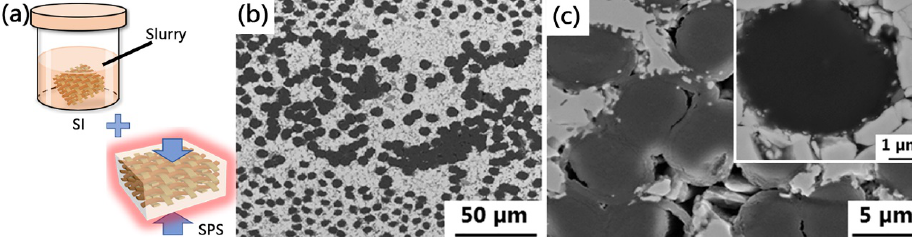
Fig. 20 Schematic diagram of vacuum slurry impregnation and SPS (a); microstructure of the polished SPS–C f /ZrB 2 –SiC composites (b, c). Reproduced with permission from Ref. [250], © Elsevier Ltd.